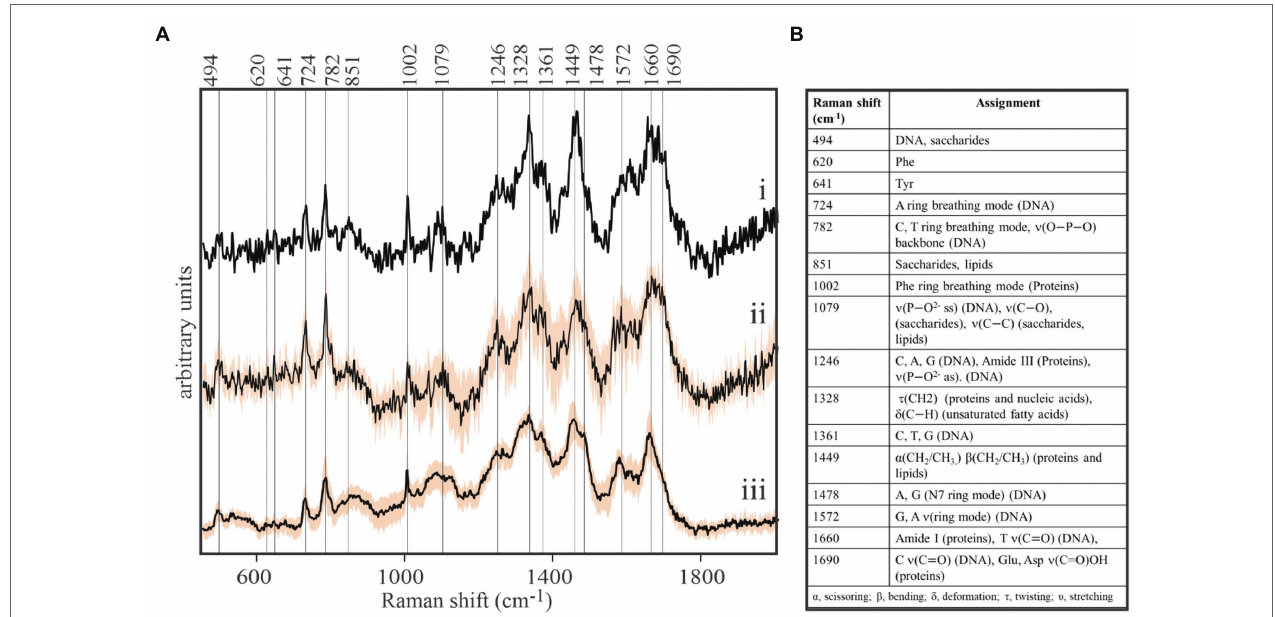
FIGURE 1 | Direct, label-free detection of individual virions by spontaneous Raman microspectroscopy. (A) Stacked Raman spectra of purified formaldehyde-fixed coccolithovirus (EhV)-163 virions deposited on stainless steel microscope slides. All spectra clearly reveal the presence of peaks characteristic of the three main components of EhV-163: proteins, DNA, and lipids. (i) Spectrum of a single virion. (ii) Average spectrum from five individual virions. (iii) Average spectrum from 20 EhV-163 aggregates. Shading over spectra (ii) and (iii) represents one standard deviation (± 1 SD) about the mean observed at every wavenumber for spectra from five individual virions or 20 viral aggregates. (B) Raman shift assignments reported for specific bonds and molecules (Movasaghi et al.,